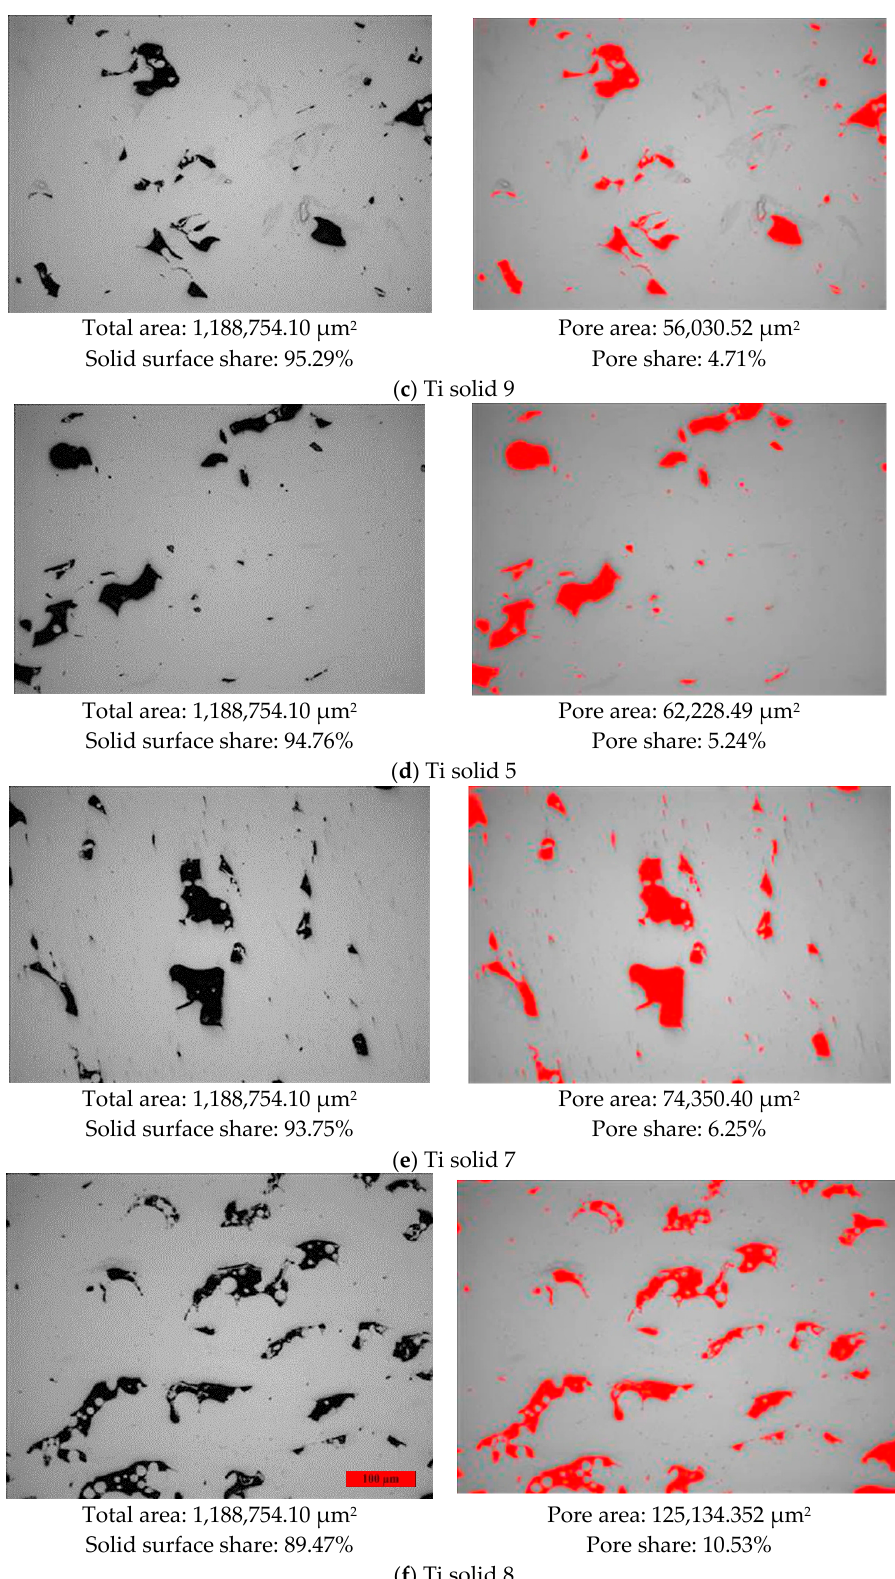
Figure 15. The share of pores in solid specimens of Ti6Al4V alloy manufactured by SLS method in various